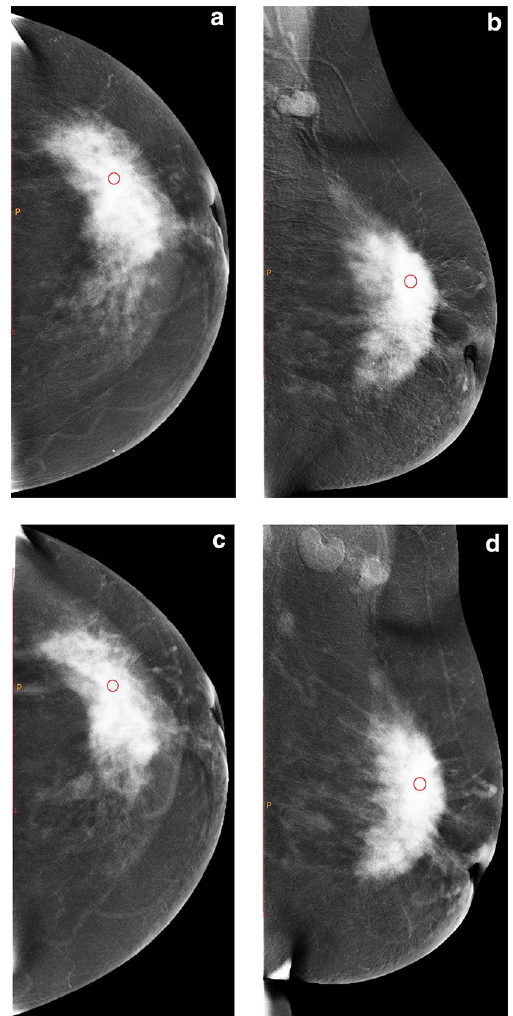
Figure 2. Female, 49 years old, with lesion located in the left outer quadrant. a and b are the subtraction images of CC and MLO views of CESM before NAC, and c and d are the subtraction images of CC and MLO views of CESM after two cycles of NAC, respectively. The CC and MLO view grey value reduction percentages were 4.02% and 4.95%, respectively. Before surgery, core needle biopsy confirmed that the patient had invasive breast cancer. After surgical resection, the pathological results showed invasive ductal carcinoma Grade II with MP Grade